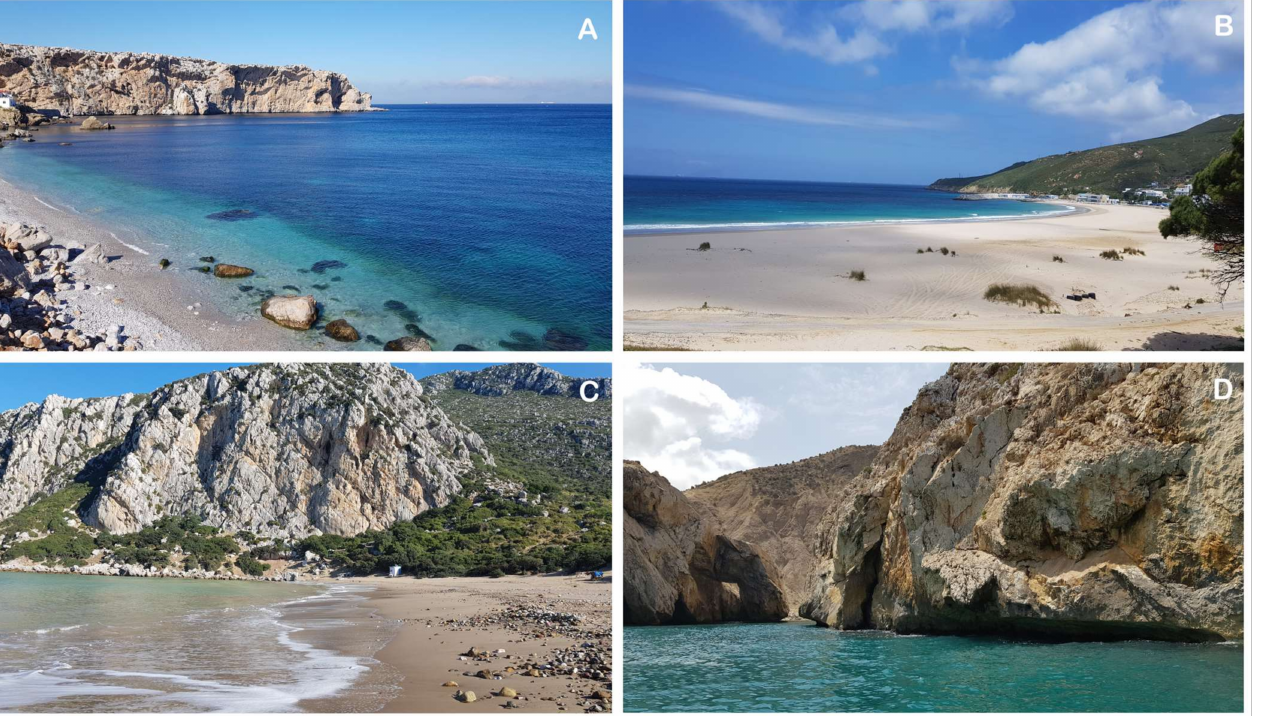
Figure 6. Examples of Class I sites, showing their exceptional natural and landscape characteristics (( A ), Belyounech 2; ( B ), Dalya; ( C ), Oued El Marsa; ( D ),